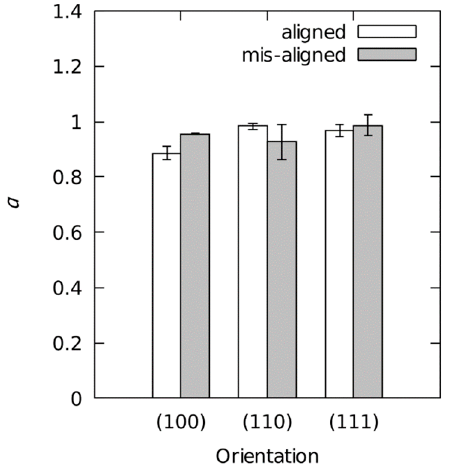
Figure 4. Dependence of the factor α on the crystal and indenter orientation. Average values with the Figure 4. Dependence of the factor 𝛼 on the crystal and indenter orientation. Average values with error bar indicating the respective range ( α max − α min ). Figure 4. Dependence of the factor 𝛼 on the crystal and indenter orientation. Average values with the error bar indicating the respective range ( 𝛼 (cid:3040)(cid:3028)(cid:3051) − 𝛼 (cid:3040)(cid:3036)(cid:3041) ) . the error bar indicating the respective range ( 𝛼 (cid:3040)(cid:3028)(cid:3051) − 𝛼 (cid:3040)(cid:3036)(cid:3041) ) .